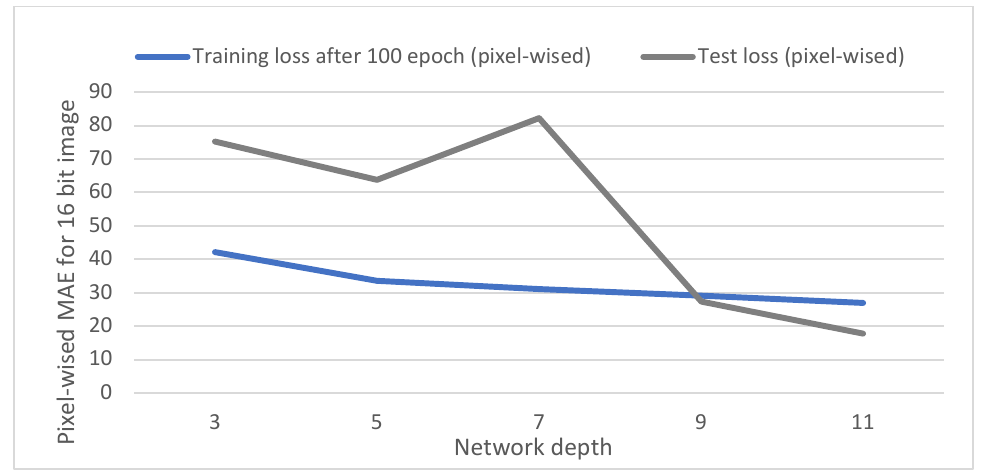
Figure 6. Network performance with different depths. The comparison of results shows test losses in both networks, and the standard deviation of test errors in Figure 7. Pix2Pix and U-Net show a similar performance in MAE, while the Pix2Pix algorithm shows a higher standard deviation of test error.